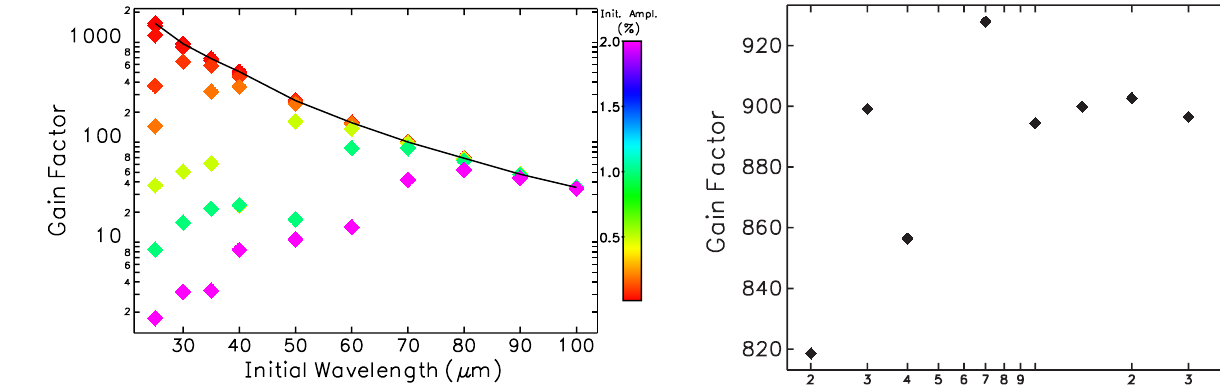
FIG. 10. (Color) Modulation gain factor of FERMI as a function of the initial wavelength of the density modulation and its